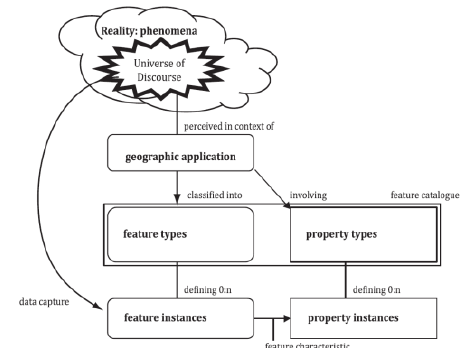
Figure 1 The process for modelling geographic information, from ISO